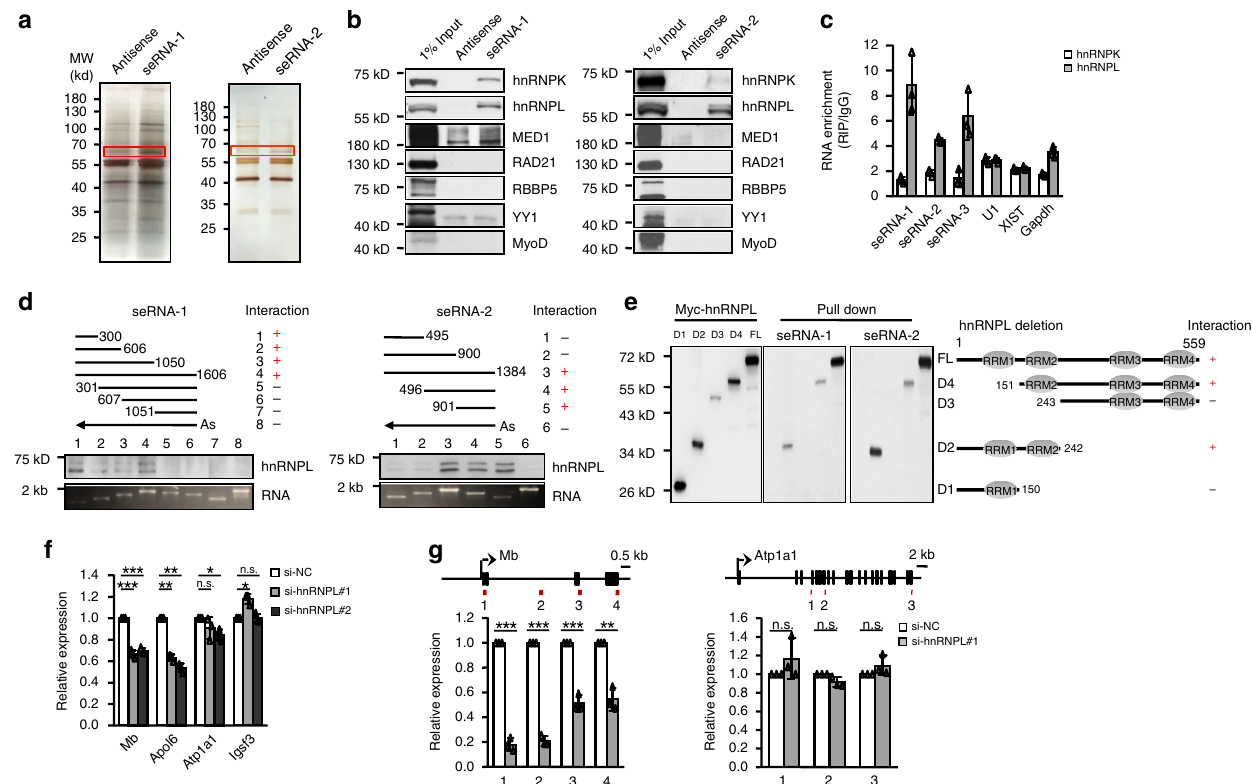
Fig. 4 seRNA-1 and seRNA-2 interact with hnRNPL. a RNA pull-down assay was performed using biotinylated seRNA or antisense control RNAs in nuclear lysates of MT cells and the puri fi ed proteins were run on SDS-PAGE. The highlighted bands were extracted and subjected to mass spectrometry (MS) analysis. b Western blot (WB) analysis con fi rmed the speci fi c association of seRNA-1 or -2 with hnRNPK and hnRNPL. No association with MED1, RAD21, RBBP5, YY1, and MyoD proteins was detected. c RNA immunoprecipitation (RIP) was performed with antibodies against hnRNPK or hnRNPL in non-crosslinked differentiating cells and followed by qRT-PCR analysis of retrieved RNAs. Enrichment was determined as RNAs associated to hnRNPK or hnRNPL IP relative to IgG control. d The indicated deletion fragments of seRNA-1 or -2 were in vitro generated and used for RNA pull-down assay to map the interacting region with hnRNPL. e The indicated Myc-tagged hnRNPL variants (D1, D2, D3, and D4) were transfected into 293 T cells and the whole cell lysates were used for RNA pull-down assay with biotinylated seRNA to map the hnRNPL domain interacting with seRNA-1 or -2. Left: Western blot showing the overexpression of the above variants. D2 and D4 interacted with seRNA-1 or seRNA-2; Right: schematic of structures of the above variants. RRM, RNA recognition motif. f C2C12 cells were transfected with siRNAs targeting hnRNPL or scrambled negative control (si-NC). At 24 h post transfection, the cells were switched to DM for 48 h. The expression of seRNA target genes was measured by qRT-PCR. g Nuclear run-on assay was performed to measure nascent transcription of Mb or Atp1a1 in the above cells transfected with si-hnRNPL#1. Data represent the average of three independent experiments ± s.d. Statistical analysis was done by two-tailed unpaired Student ’ s t -test ( f , g ), n.s., not signi fi cant, * P < 0.05, ** P < 0.01 and *** P < 0.001. Source data are provided as a Source Data fi